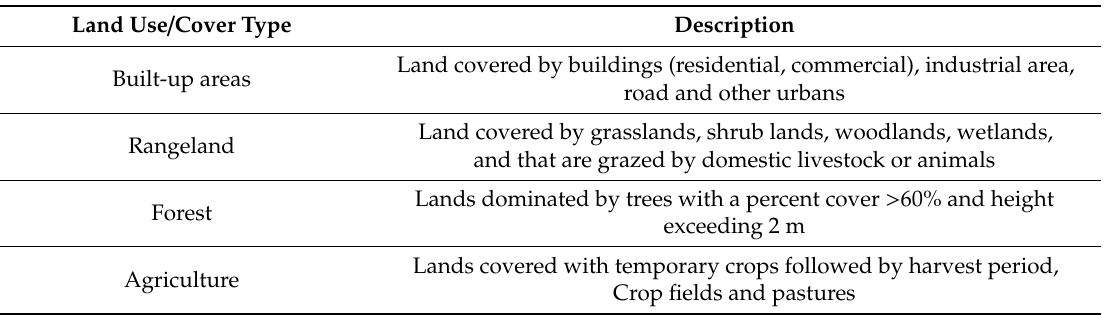
Table 2. Land use / cover